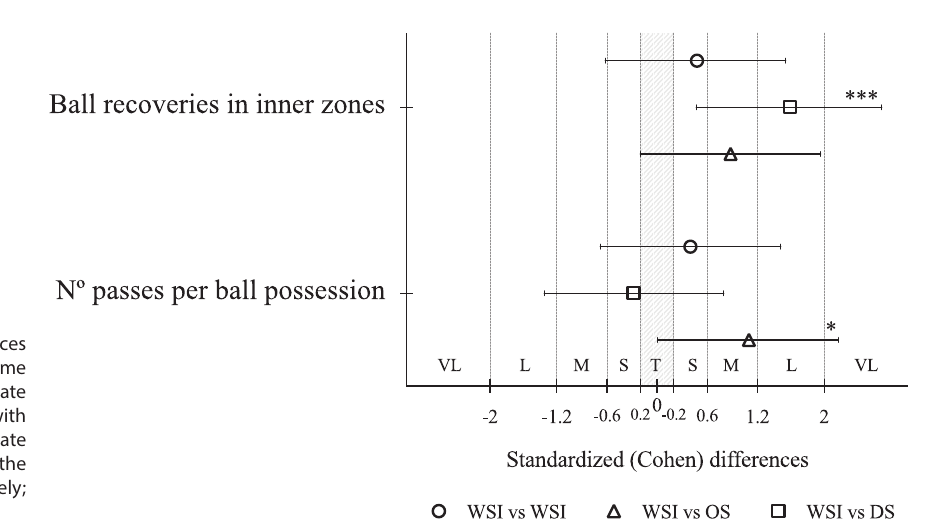
FIGURE 1 Standardized (Cohen) diff erences in technical variables according to the game scenarios’ comparisons. Error bars indicate uncertainty in the true mean changes with 90% confi dence intervals. Asterisks indicate the likelihood for the magnitude of the true diff erences in mean as follows: *likely; ***most